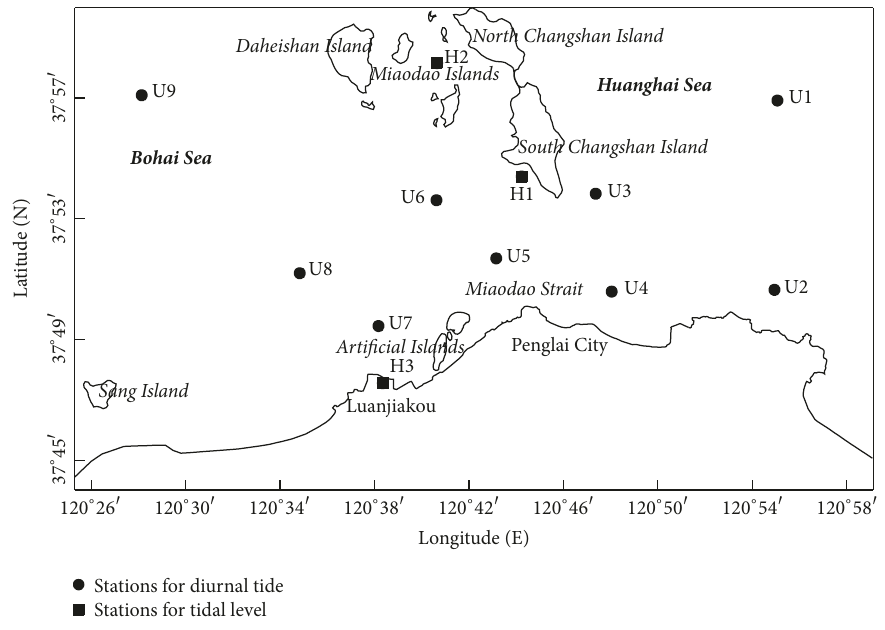
Figure 1: Map of the Luanjiakou District near the Port of Yantai and survey